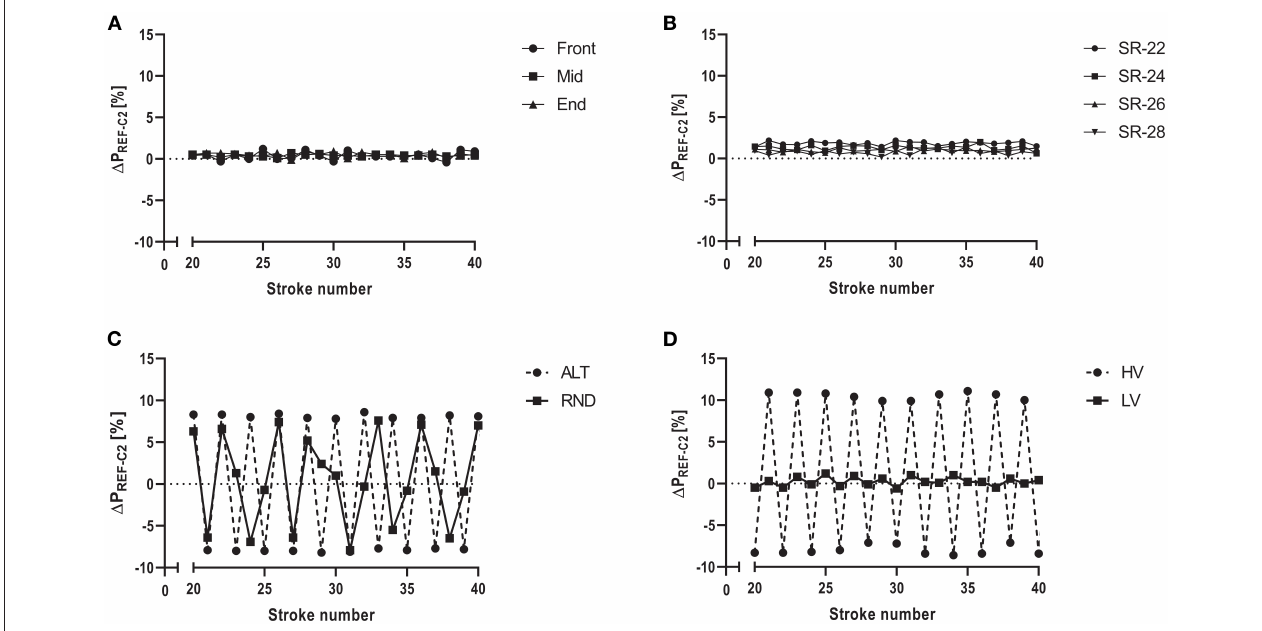
FIGURE 2 | Differences in mechanical power output between the reference system of a test rig for air-braked rowing ergometers and the Concept 2 Indoor Rower’s PM5 Monitor ( 1 P REF − C2 [%]). (A–D) show arithmetic mean of 10 repeated measurement series for strokes 20–40 (A) Different stroke shapes, i.e., front-, mid- and end-emphasized strokes during steady rowing. (B) Four different stroke rates, corresponding to 22, 24, 26, and 28 min − 1 during steady rowing. (C) Persistent variations in stroke force within the measurement series either by regular (ALT) or random (RND) alterations causing unsteady rowing. (D) Persistent regular or